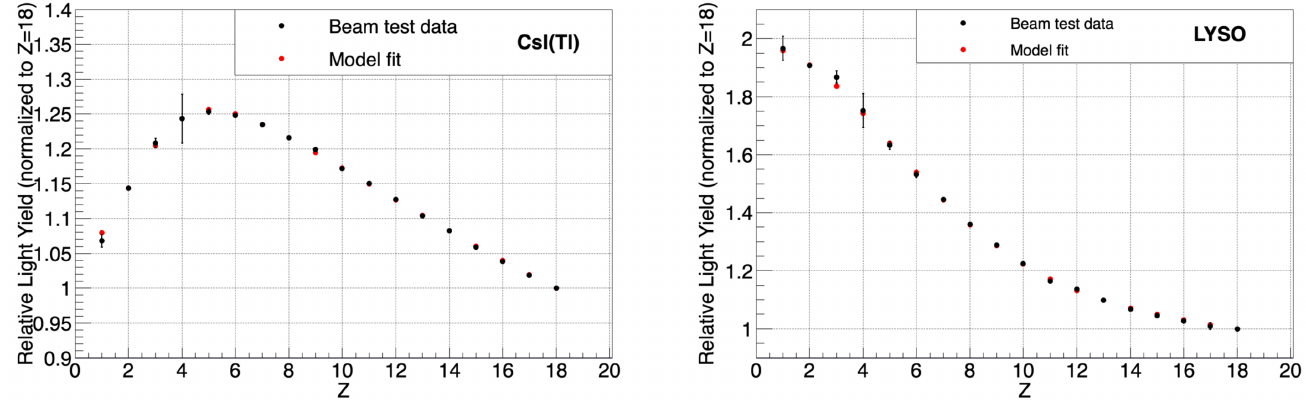
Figure 4. Different markers show the mean of the light signals obtained with different crystals crossed by different high-energy nuclei, divided by Z 2 , and plotted as a function of Z. The dashed line represents the noise level [16].